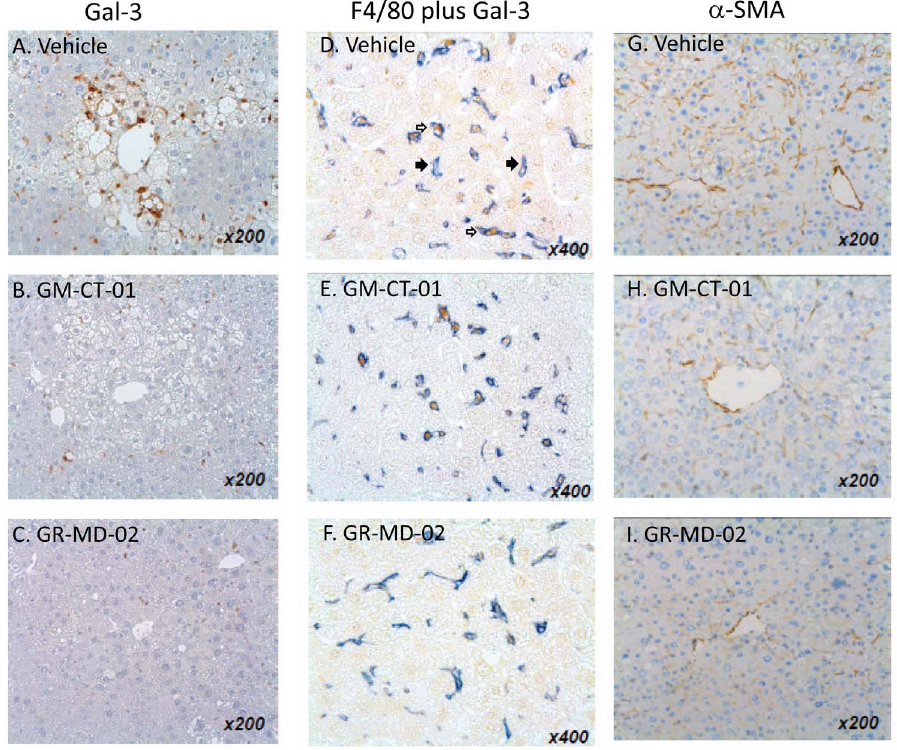
Figure 6. Liver immunohistochemistry. A–C : Gal-3; D–F : F4/80 plus Gal-3; G–I : a -SMA. Immunohistochemistry was performed on liver sections from the late treatment cohort was treated with vehicle (0.9% NaCl, A, D, and G), GM-CT-01 (120 mg/kg, B, E, and H), and GR-MD-02 (60 mg/kg, C, F, and I) each administered intravenously twice weekly. Closed arrows indicated cells that stain only with F4/80 antibody (blue) and open arrows indicate cells that stain with F4/80 antibody (blue) and galectin-3 antibody (brown).